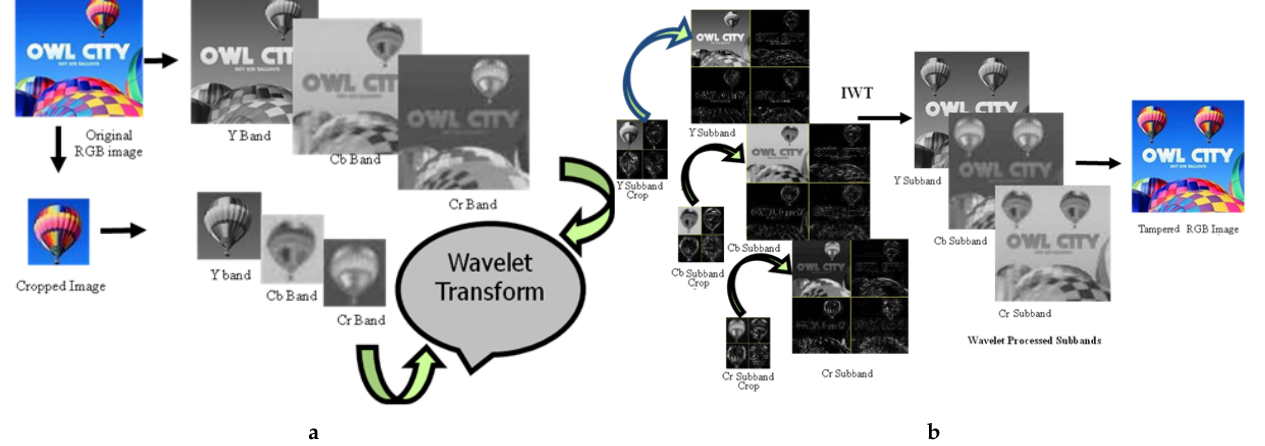
Figure 4. DWT domain tampering. ( a ) Transforming into DWT domain, ( b ) Copy/paste and subsequent